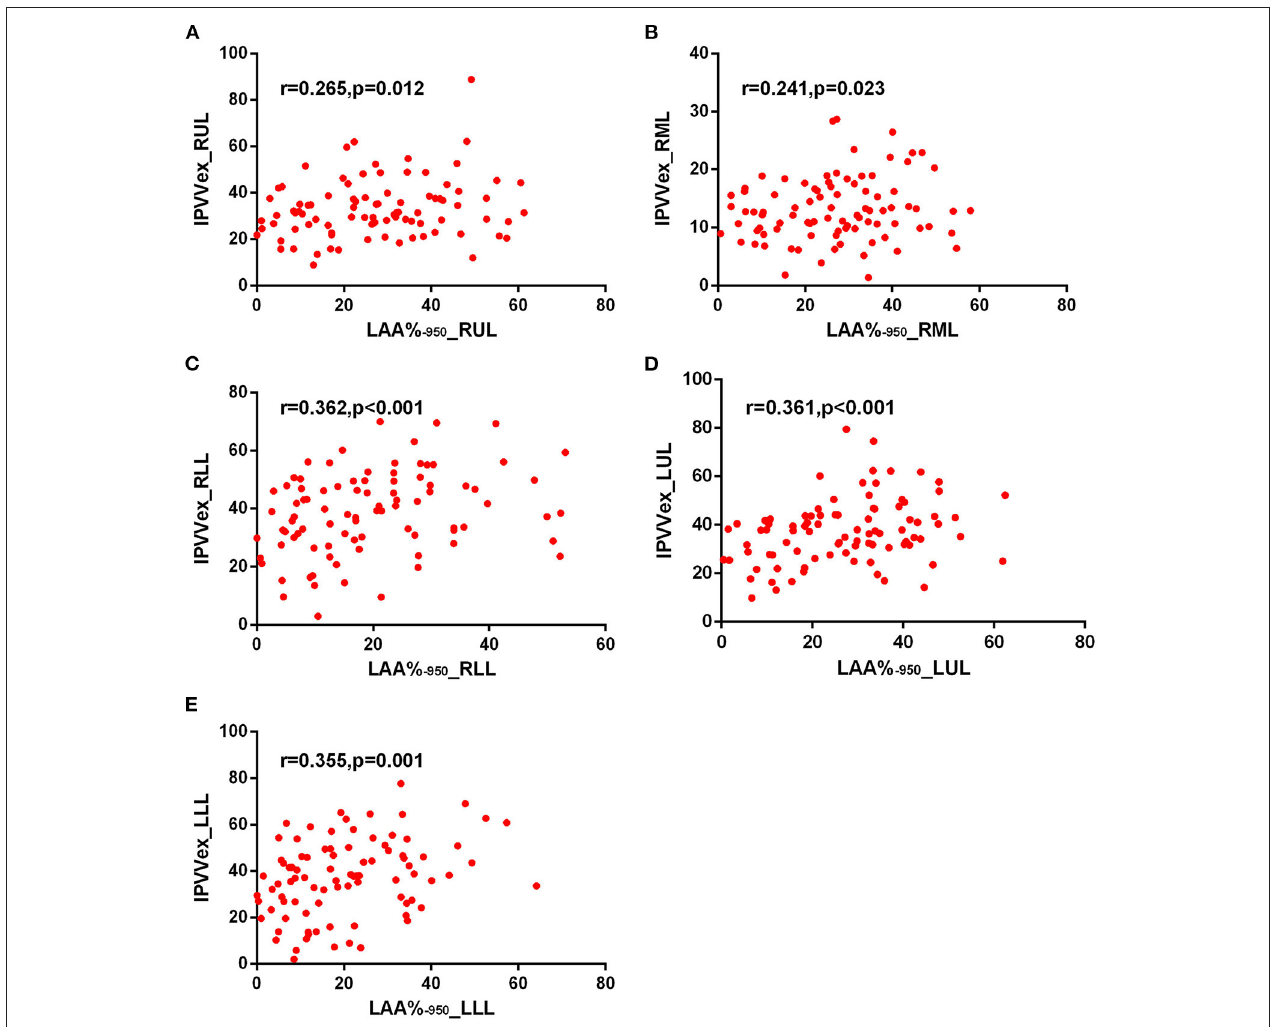
FIGURE 6 | Correlations of IPVV in individual lobes with LAA% − 950 in the expiratory CT scan. (A) RUL; (B) RML; (C) RLL; (D) LUL; (E)